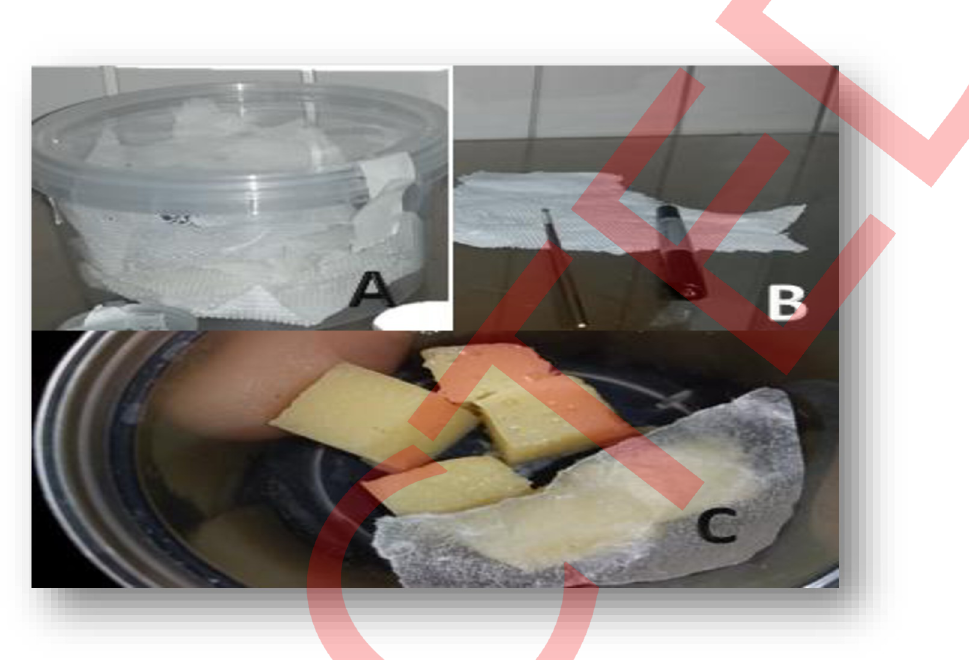
Fig 3. A: plastic cup possessed many neonates. B: Shifting of neonates using camel hair brush. C: Rearing cup possessed larvae from starter culture. https://doi.org/10.1371/journal.pone.0258431.g003 suggested formulations. Details of each diet composition are given in Tables 1 and 2. To avoid fungal contamination during diet preparation, firstly sterilized required equipment with 5% ethanol solution (25ml water) followed by autoclave were used. The standard diet prepared based on the technique suggested by [15] is given in Table 1. All ingredients were accurately weighed using electronic balance followed by three fractions (A, B, and C) of ingredients so a well mixed product can be obtained. Fraction A ingredients stirred well in 230 ml of distilled water in a 1000ml of measuring beaker. Then fraction B comprised of decavitamins (0.0l ml) was separately mixed in 10 ml of water in a measuring cylinder to make vitamin solution and then fraction C comprised of agar as a thickening agent was separately well stirred in 500ml of distilled water in a 1000ml of measure beaker followed by boiling it in the oven to make a uni- form agar solution. After making fraction solutions, all fractions were blended step by step Table 1. Wheat germ meal artificial diet and its gradients used in this study. Components of Fraction